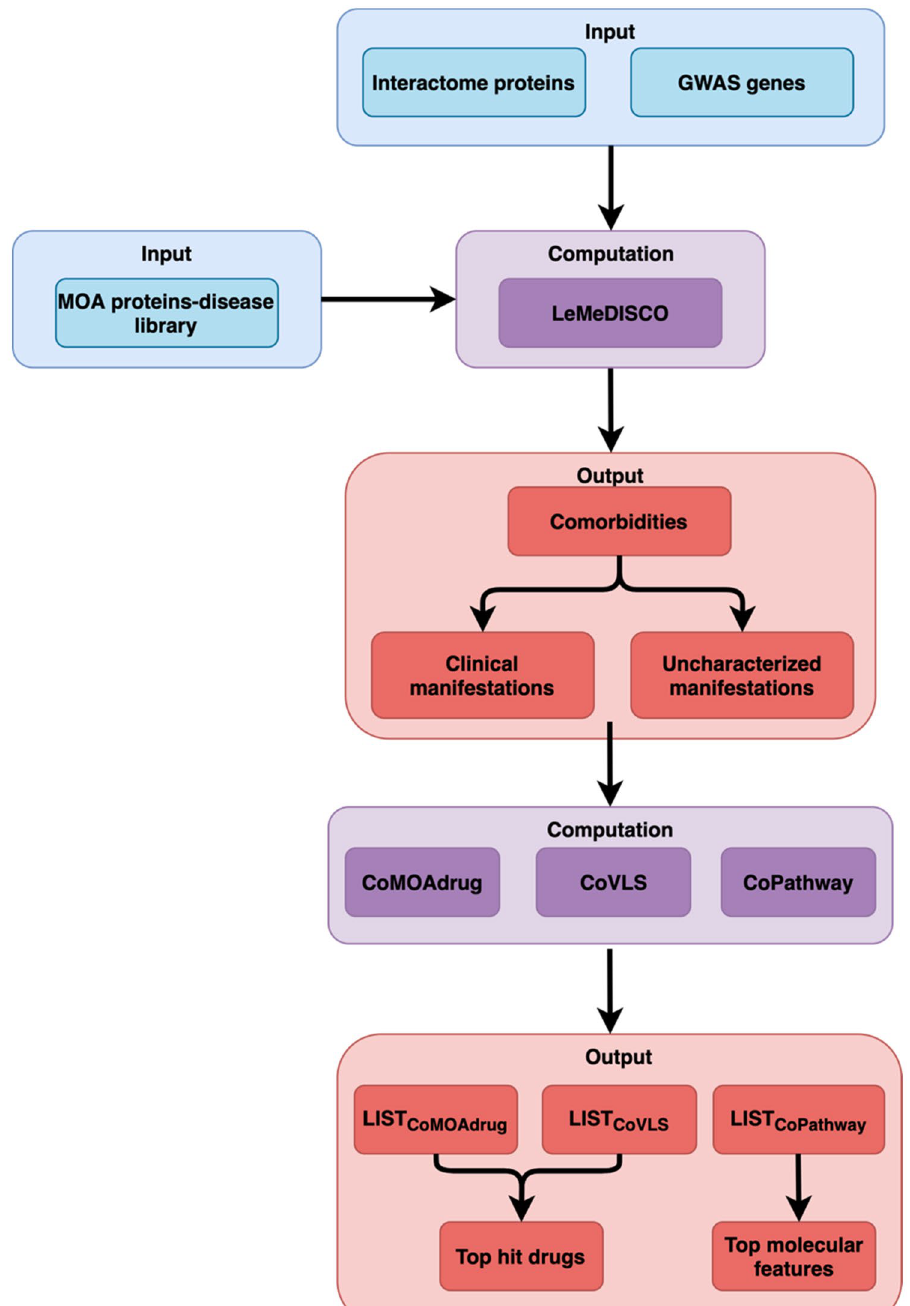
Figure 1. Overview of the MOATAI-VIR approach that predicts comorbid human diseases, their MOA proteins, and repurposed drugs to address the severe secondary adverse events. Blue are MOATAI-VIR inputs, purple algorithms and pink output